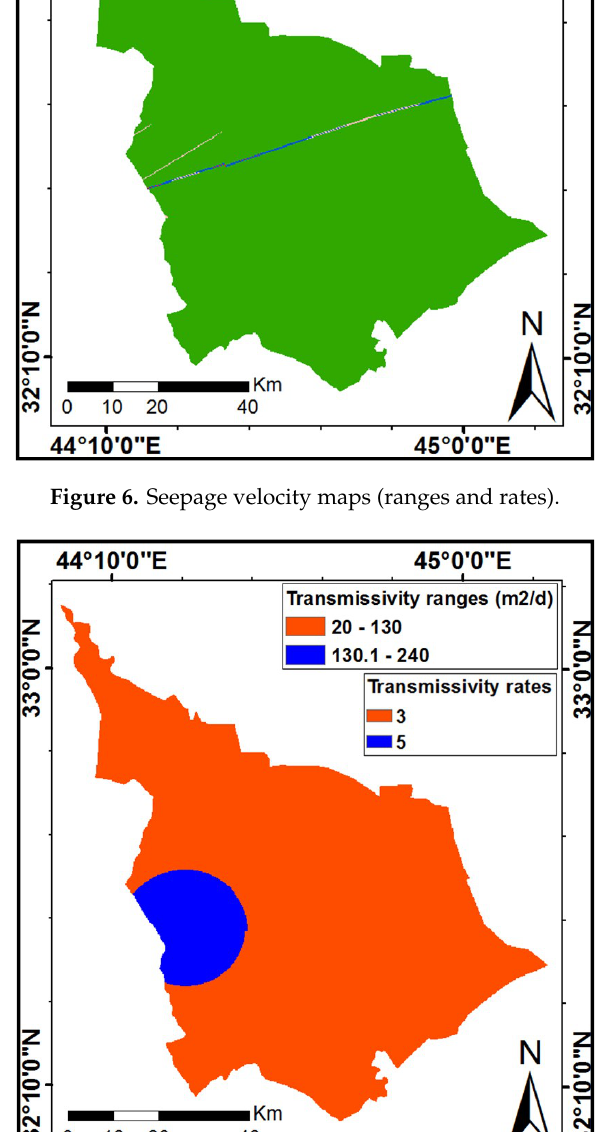
Figure 8 . Saturated thickness maps (ranges and rates).